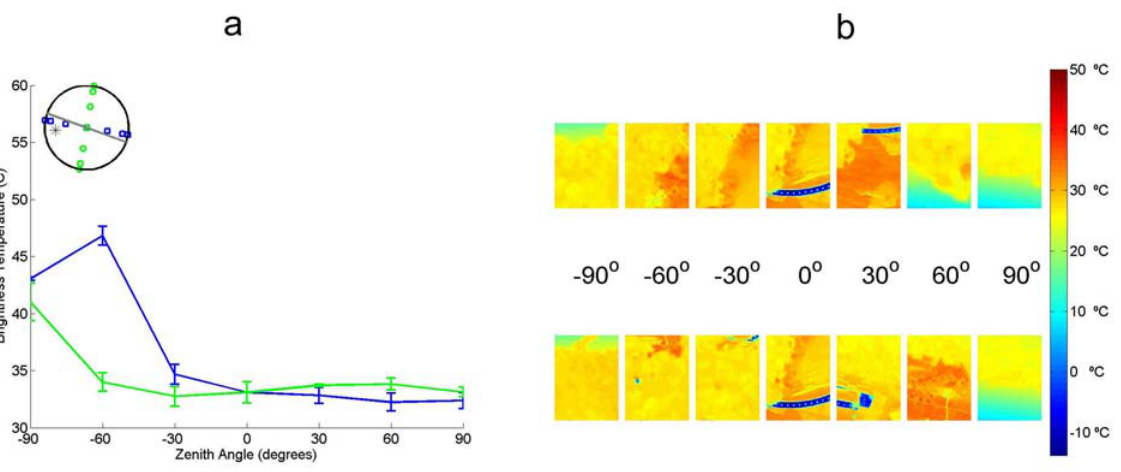
Figure 9. Comparison of CIMEL and Thermotracer acquired brightness temperatures.